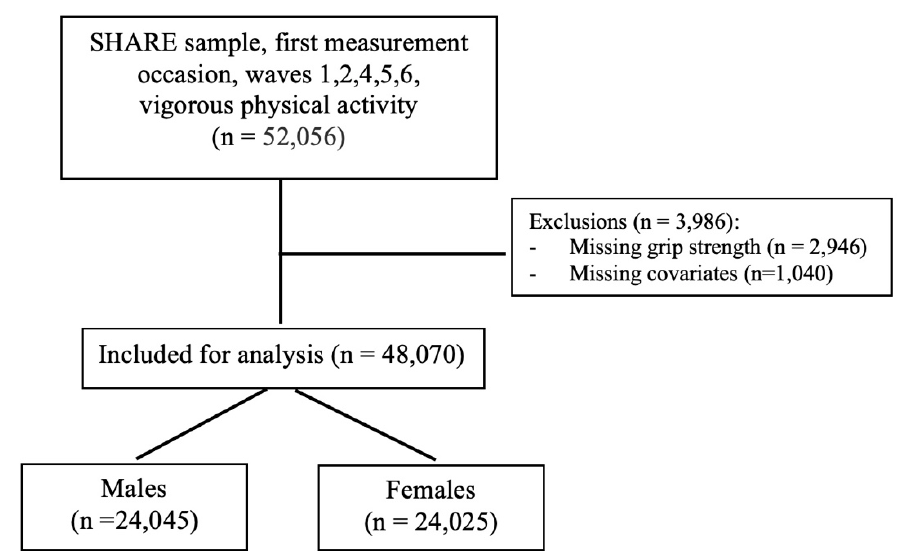
Figure A1. Study flow diagram.